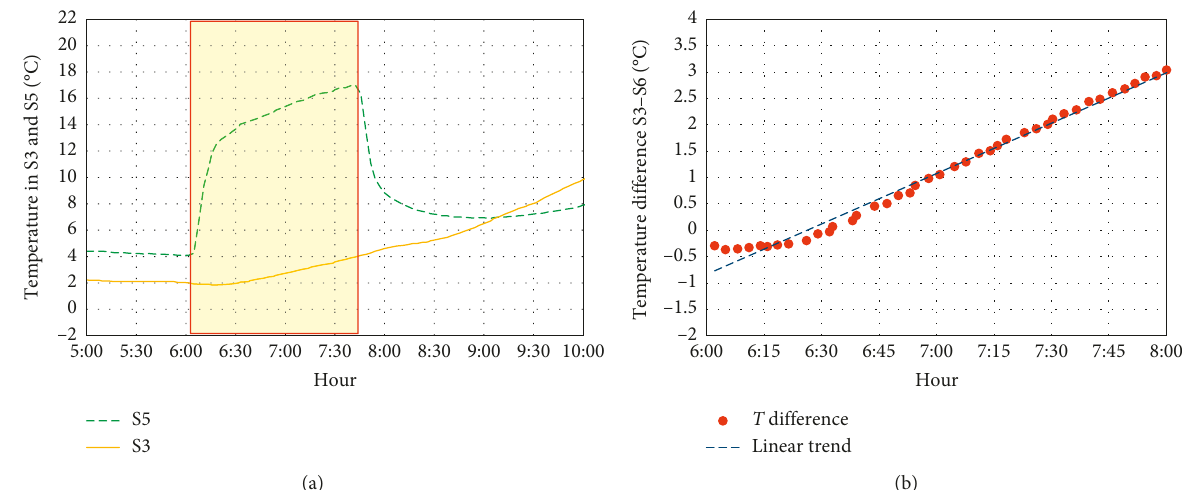
Figure 9: (a) S3 (surface) and (b) S5 (ribbon) temperatures and temperature difference recorded on the surface between R10 and NR10.